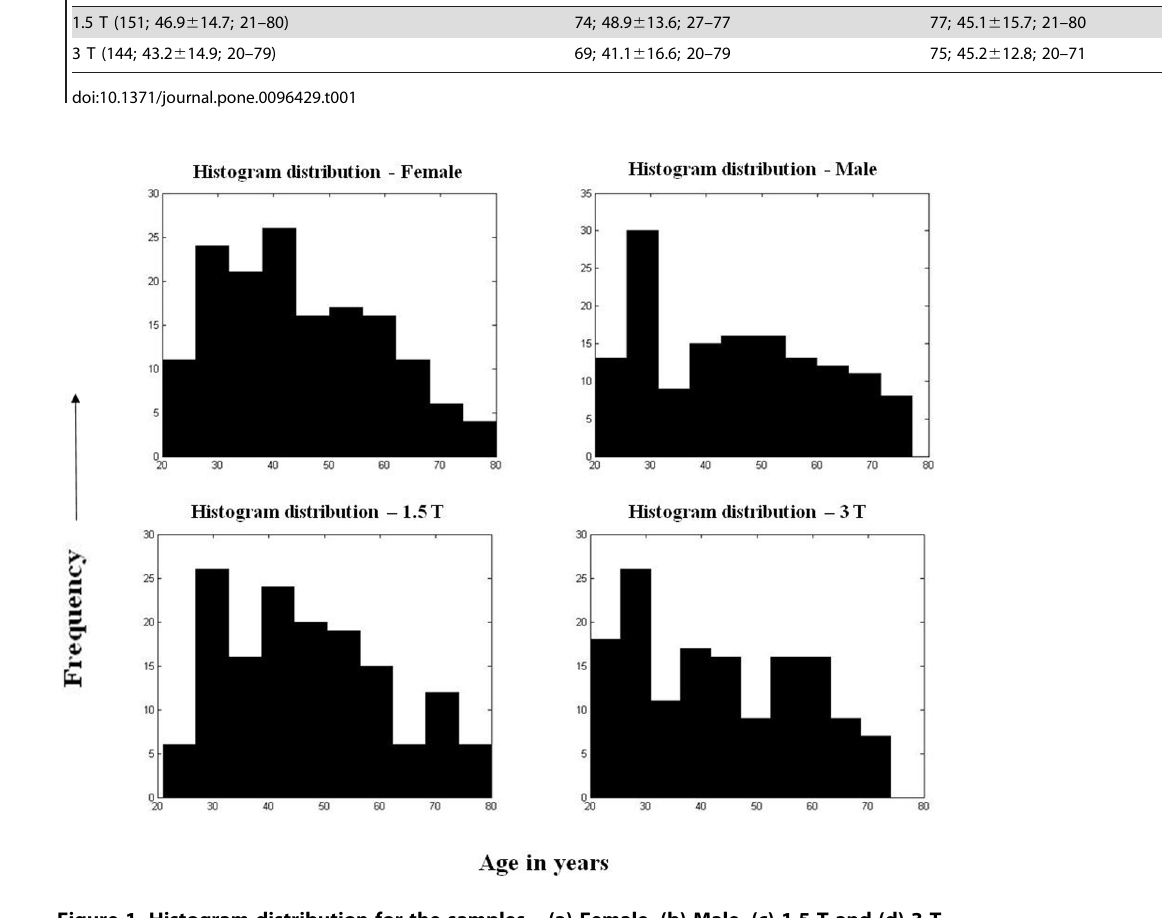
Figure 1. Histogram distribution for the samples – (a) Female, (b) Male, (c) 1.5 T and (d) 3 T.